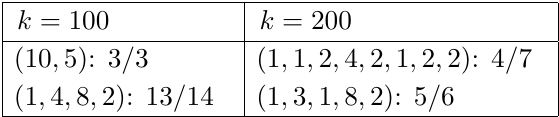
Table 3 . Kaq ness for L 24 on su (4) .